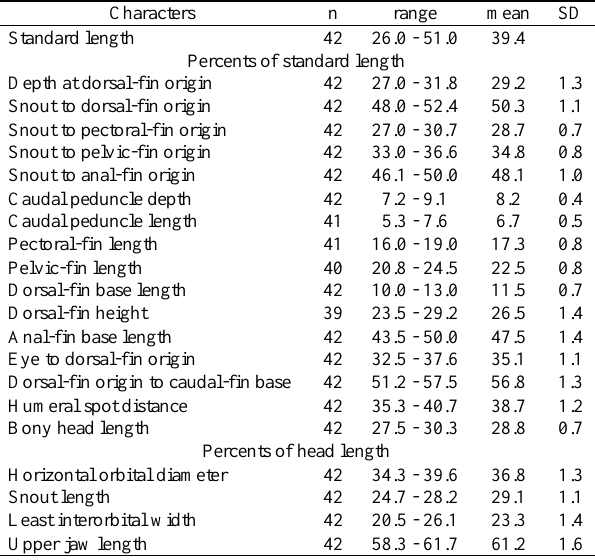
Vertebrae 31-33 (3). Seven to 8, 7.5 gill-rakers on lower limb of first gill-arch. Branchiostegal rays 4, 3 rays originating from anterior cerathyal and 1 from posterior ceratohyal. Color in alcohol. Body pale to light yellow, slightly darker dorsally due to denser concentration of dark chromatophores. Ventral region of body lightly colored with scattered dark chromatophores especially anteriorly. Roundish dark humeral blotch extending about 4 scales horizontally and 4.5 to 5 scales vertically, darker on central part due to denser concentration of dark chromatophores. Dorsal regions of head, snout and tip of lower jaw darker than remaining portions of head; dark Table 3 . Morphometrics of Charax condei . Specimens